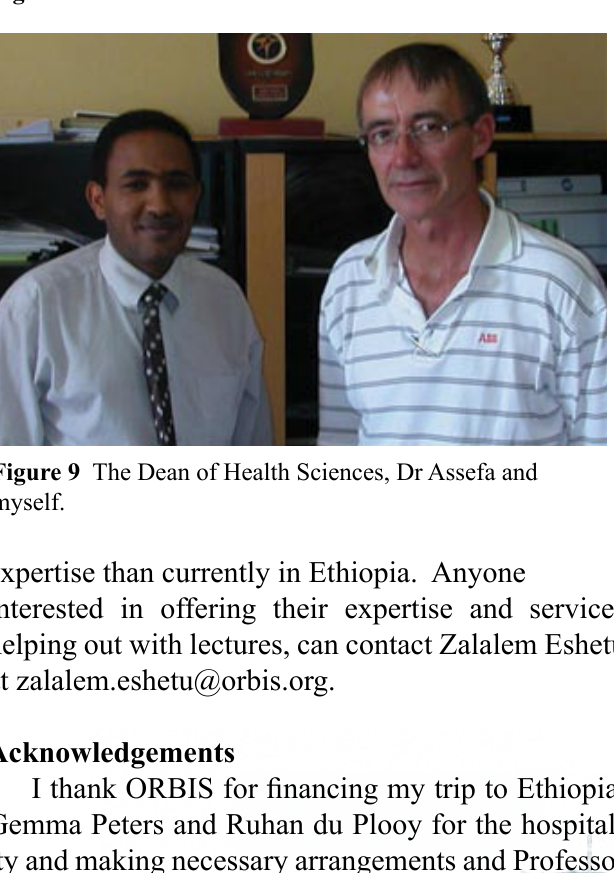
Figure 8 The entrance to the Dean’s office.